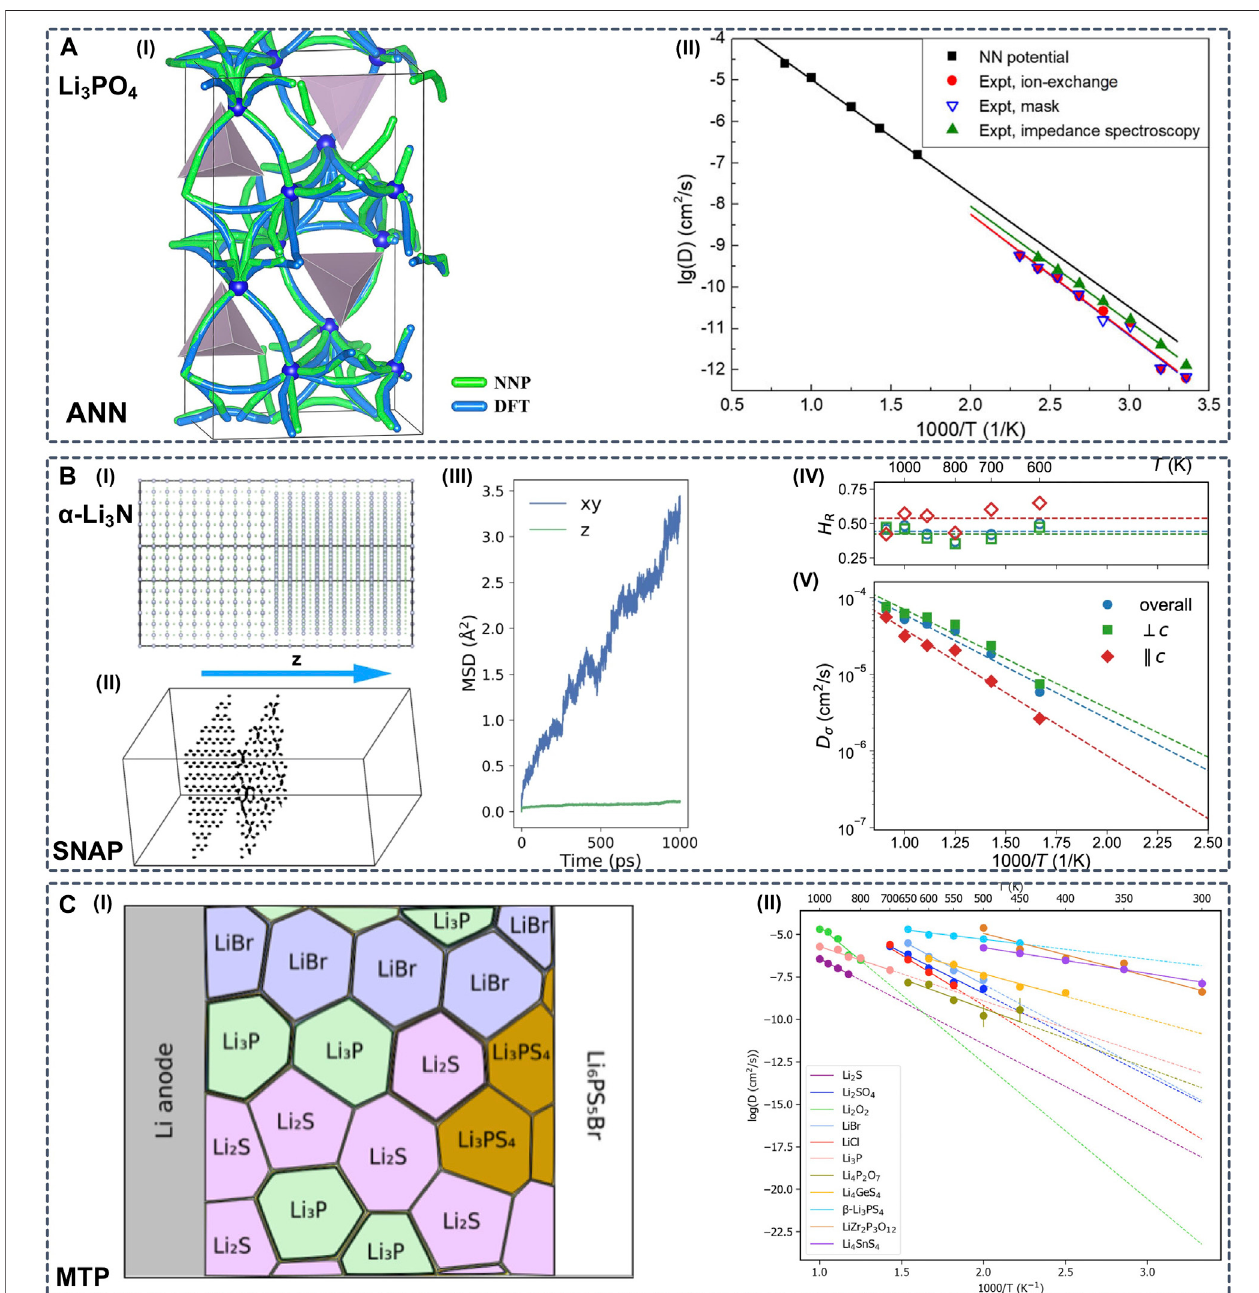
FIGURE 6 | (A-I) All diffusion paths of Li atoms in the amorphous Li 12 P 4 O 16 model, predicted by DFT and ANN potentialcalculations with the nudged elasticband (NEB) method (A-II) Arrhenius plot of the Li diffusivity in amorphous Li 3 PO 4 . The simulation results were obtained from large-scale MD simulations of 1,006 atoms using ANN potentials. The experimental results were measured withdifferent methods. Reproduced with permission from (Li et al., 2017a). Copyright 2017American Institute ofPhysics (B-I) Constructed simulationbox of α -Li 3 Nwithtwist Σ 7[0001] grainboundaries (GBs) (B-II) Trajectoriesfor selected Liionsinthe boxwith twist GBsin 0.5 ns. Liionsontheleftlieinthebulkregion,andtheonesontherightareclosetooneoftheGBs (B-III) Meansquareddisplacement(MSD)bycomponentvs.time for Li ions located at the twist GBs only (bulk Li ions are excluded). The z direction is perpendicular to the GBs. Diffusivity is computed within the 2D GB plane (B-IV) Haven ratio and (B-V) Arrhenius plot for Li charge diffusivity in bulk α -Li 3 N obtained from eSNAP MD simulations. Reproduced with permission from (Deng et al., 2019). Copyright 2019 Nature (C-I) Arrhenius plot of diffusivities of possible interphase components obtained from LOFT-MD (C-II) Schematic diagram of phase equilibria at the interfacebetweentheLianode and solidelectrolyte Li 6 PS 5 Br. Reproduced withpermission from (Wanget al.,2020a).Copyright 2020AmericanInstituteofPhysics.